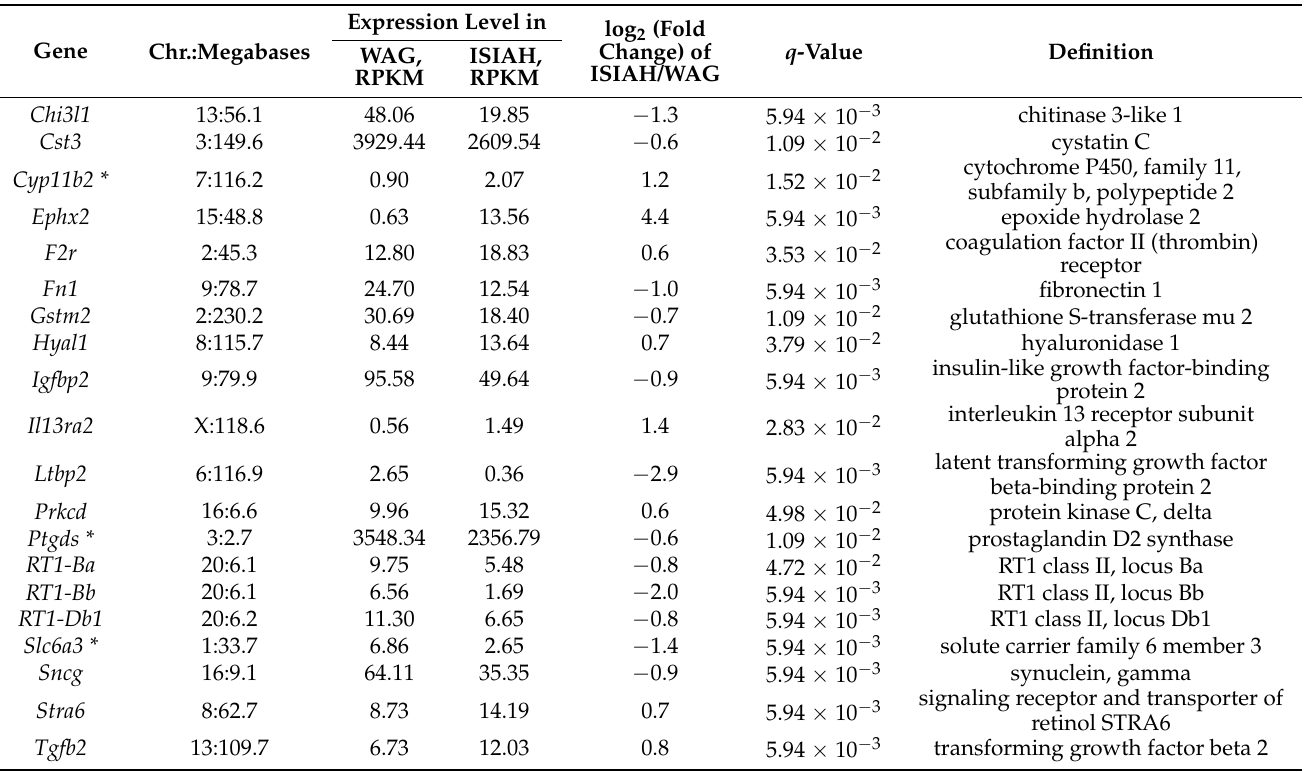
Table 3. Hypothalamic DEGs associated with hypertension.